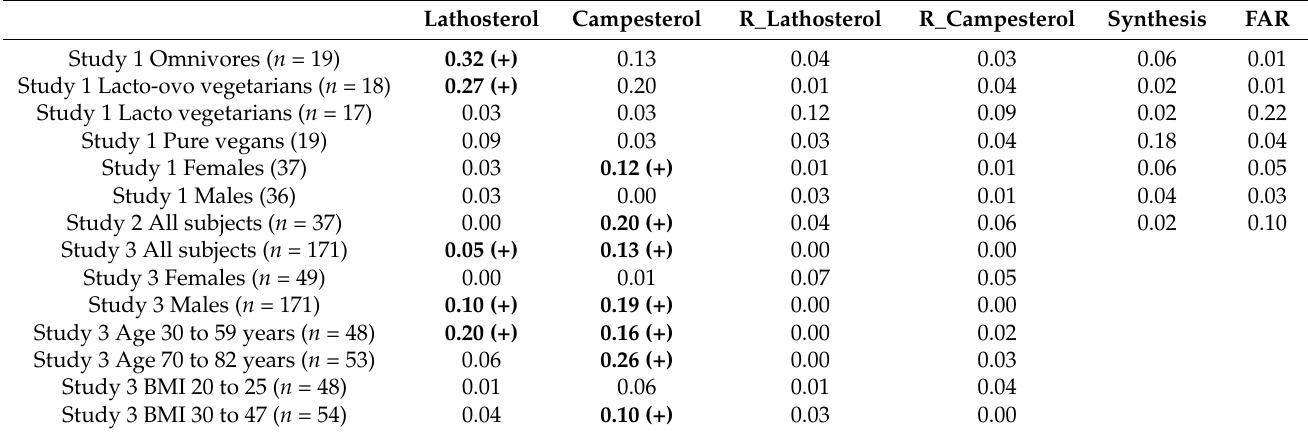
Table 2. R_square data for the linear regression evaluating associations between serum LDL-C concentrations and various parameters expressing C synthesis and C